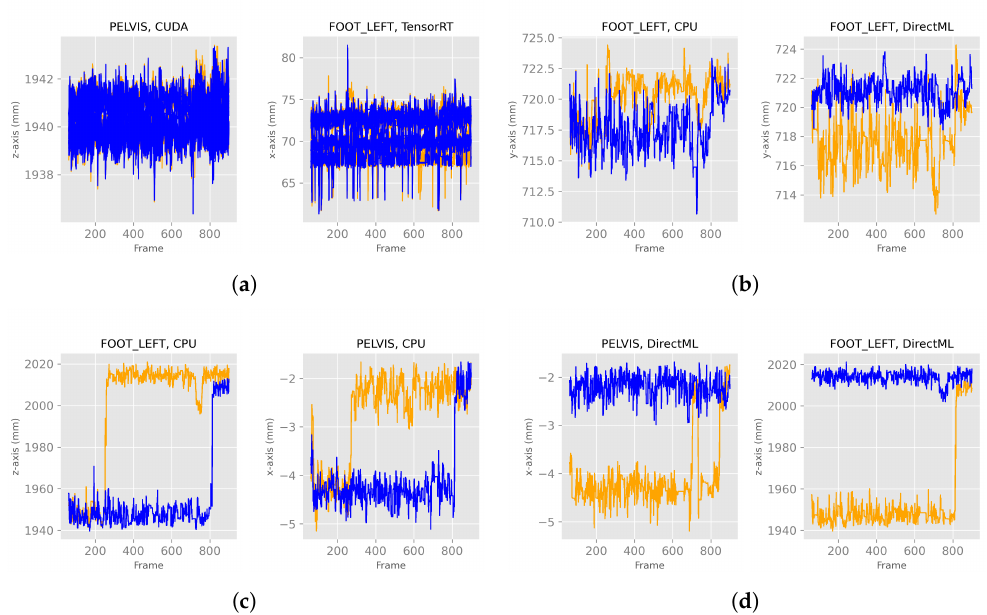
Figure 13. X -, y -, and z -axes of the joint positions of PELVIS and FOOT_LEFT for all four processing modes for two different computers—extract of relevant graphs (Figures for all processing modes and axis are shown in Figure A2). The blue lines represent computer A, and the orange ones computer B. ( a ) Examples of similar behavior between computers A and B. ( b ) Examples of very close steady value ranges for computers A and B. ( c ) Examples of a switch between two steady value ranges at different frames. ( d ) Examples of a switch between two steady value ranges just for one